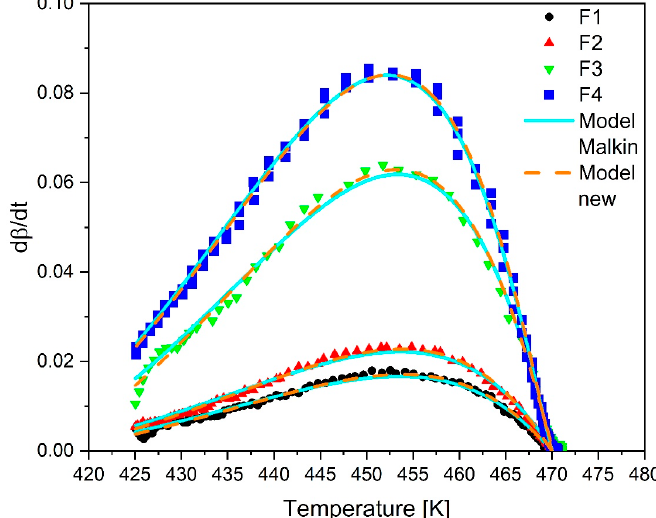
Figure 5. Comparison of measured values with the Malkin model and the extended model.